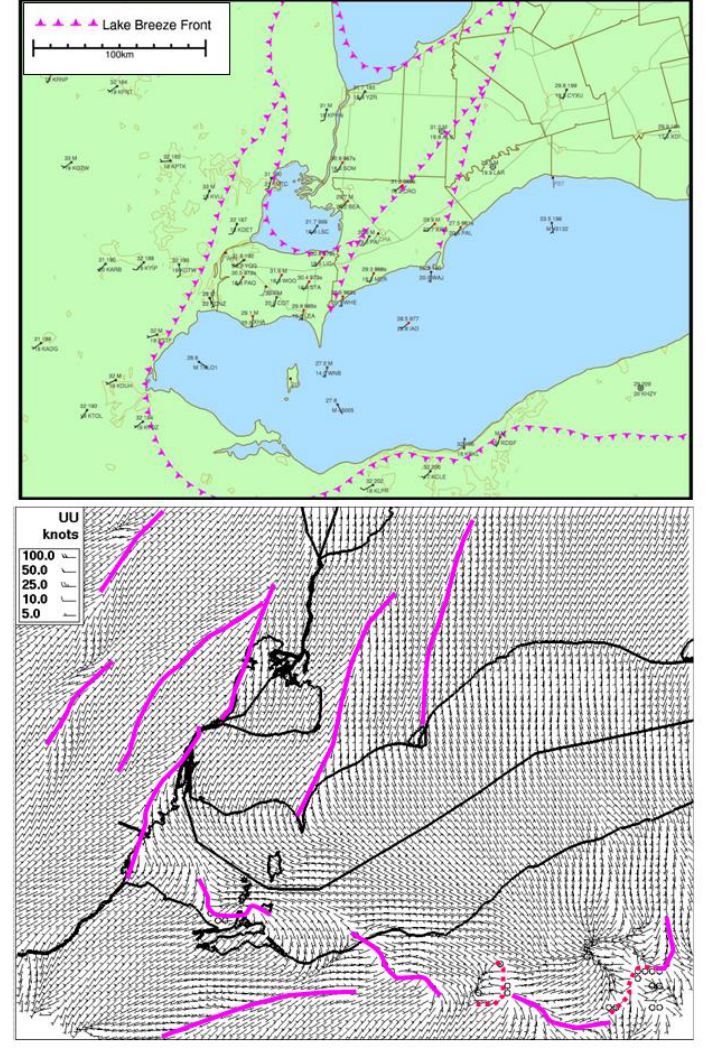
Fig. 7. 26 June, 23:00 UT (07:00p.m. local time) (a) meso-analysis lake-breeze front locations; (b) lake-breeze front locations inferred from convergence pattern of 2.5-km resolution model